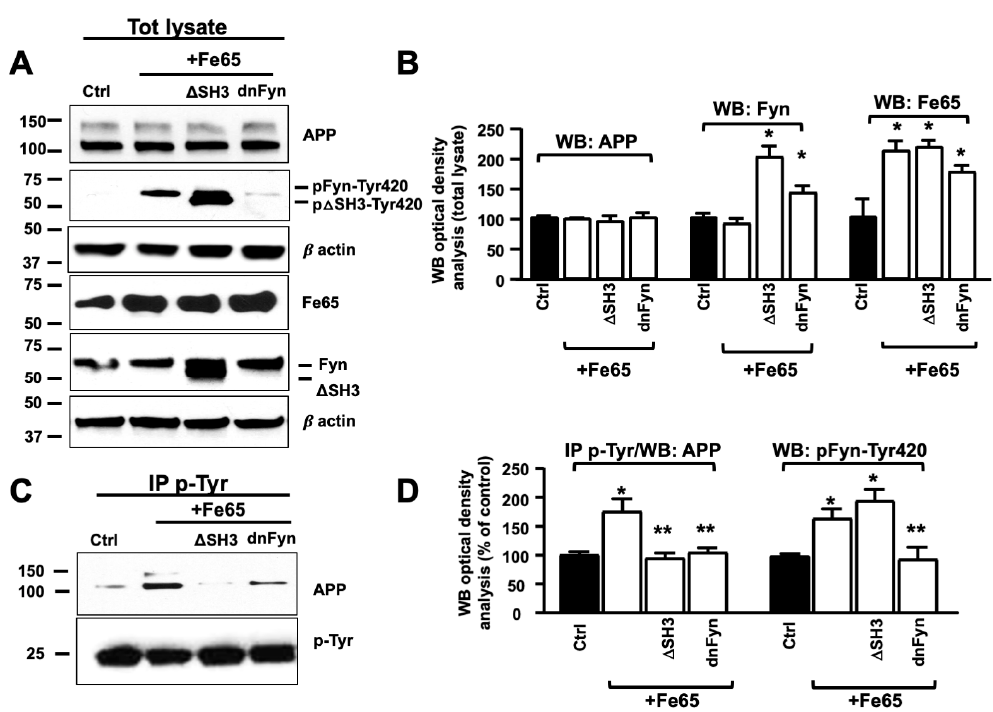
Figure 4. Fe65 controlled Fyn-mediated APP phosphorylation at Tyr. ( A ) WB analysis of APP, Fyn, pFyn-Tyr420, and Fe65 proteins in total lysates from Fe65, Fe65 + Fyn, Fe65 + ∆ SH3, and Fe65 + dnFyn neurons. The densitometric analysis is reported in ( B ). Densitometric analysis of pFyn-Tyr420 is reported in ( D ) instead. The data were normalized to β -actin values and were expressed as a percentage of Ctrl (empty vector). n = 3. * p < 0.05, vs. control. ( C ) Samples were immunoprecipitated with mouse anti-pTyr magnetic beads and analyzed by WB using rabbit anti-APP or rabbit anti-Fyn antibody. pAPP-Tyr optical density analysis is reported in ( D ). Values were calculated by dividing pAPP-Tyr or pFyn-Tyr420 optical density values by the corresponding APP or Fyn optical density values in total lysates, respectively. Statistically significant differences were calculated using one-way ANOVA followed by Dunnett’s post hoc test. n = 3. * p ≤ 0.05, vs. control; ** p ≤ 0.05, vs. Fe65+Fyn.